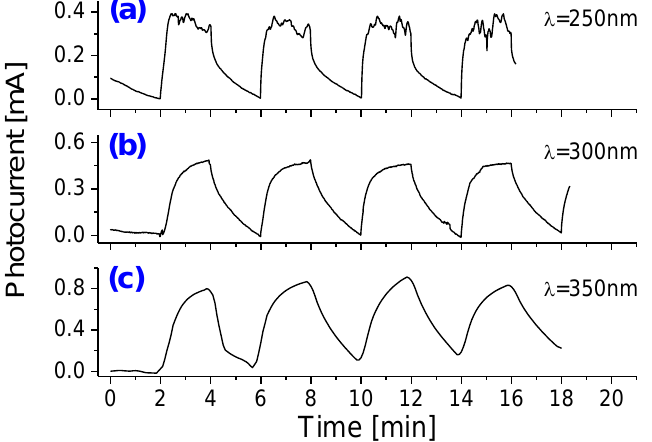
Figure 5. Photocurrent responding to 2 mW/cm 2 UV signals of a period of 4 min and a 50% duty cycle at ( a ) 250 nm, ( b ) 300 nm, and ( c ) 350 nm, respectively, when operating at room temperature and 3.5 V bias voltage.